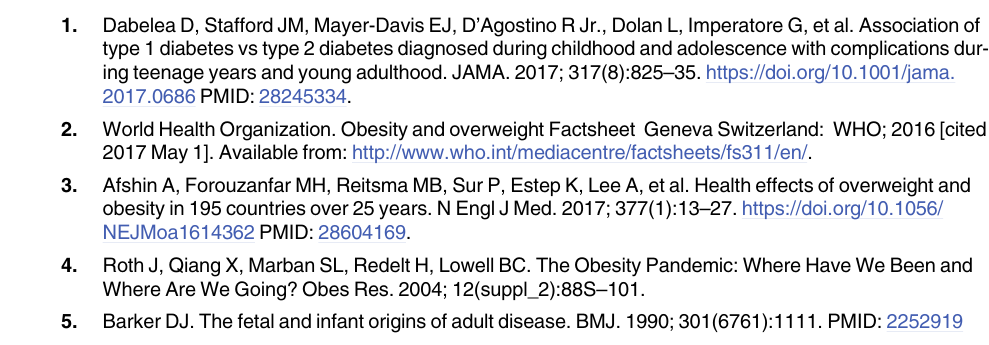
PLOS Medicine| https://doi.org/10.1371/journal.pmed.1002415 October 31,